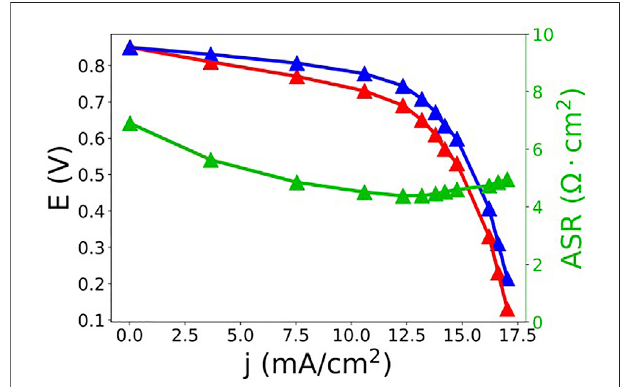
FIGURE7| Raw(red)andiR-compensated(blue)polarizationcurveand ASR (green) data for a ferrocene (192 mM) - menadione (89 mM) SDS microemulsion (28% toluene, 9% SDS, 9% 1-butanol, 54% KNO 3 aq., by mass)